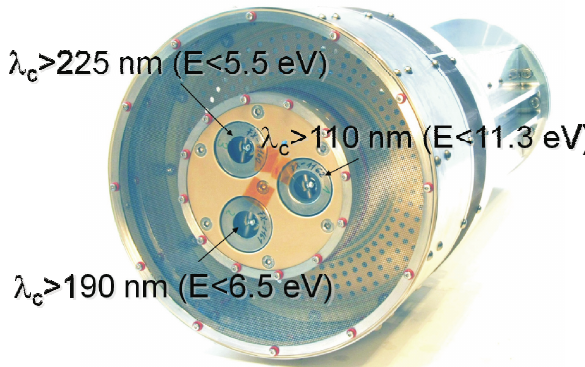
Fig. 1. Photograph of the modified ECOMA particle detector with three flashlamps employing three different window materials and, hence, different wavelength cutoffs. The used flashlamps are sup- plied by Perkin Elmer, product numbers FX1162 (cutoff wave- length at 110nm), FX1161 (cutoff at 190nm), and FX1160 (cutoff at